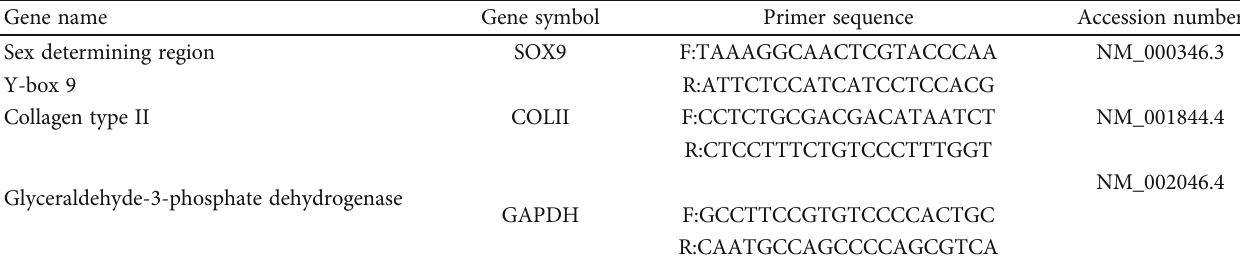
Table 1: Primer sequences for quantitative RT-PCR